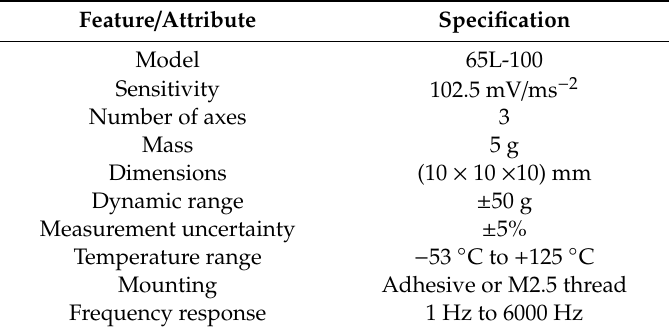
Table 1. Endevco 65L-100 accelerometer specifications.